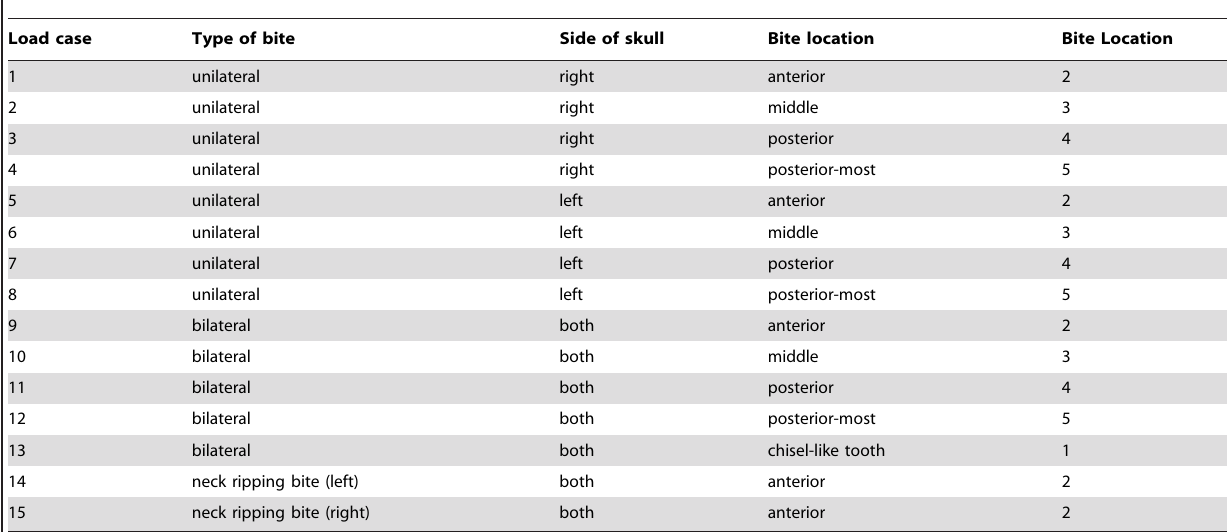
Table 1. The 15 load cases simulated during the MDA and applied in the FEA.